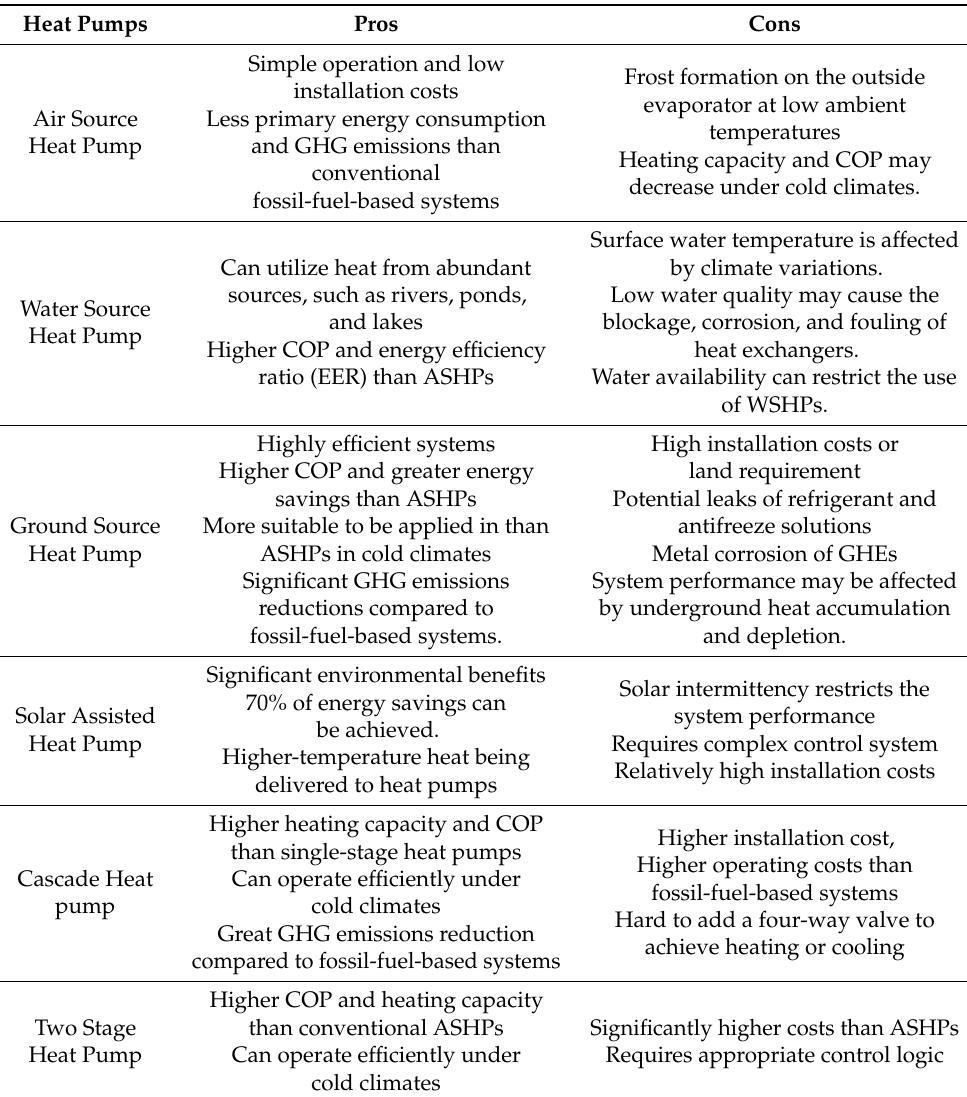
Table 7. Summary of pros and cons of various heat